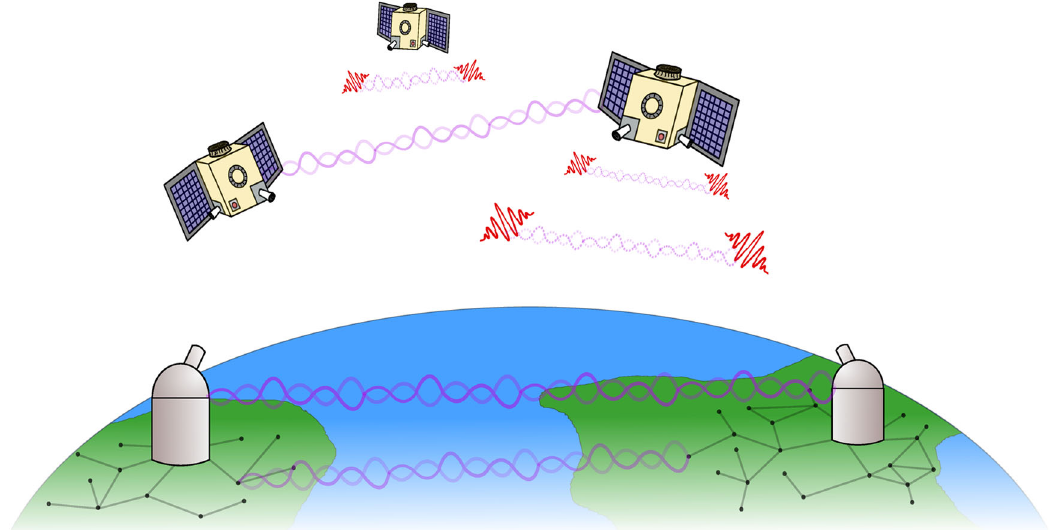
Fig. 1 A hybrid global quantum communications network. A satellite constellation distributes entangled photon pairs (red wave packets; entanglement depicted by wavy lines) to distant ground stations (observatories) that host multimode quantum memories for storage 114 – 116 . These stations act as hubs that connect to local nodes (black dots) via fi ber-optic or atmospheric links. Using these nearest-neighbor entangled links, via entanglement swapping, two distant nodes can share entanglement. Note that this architecture can support inter-satellite entanglement links as well, which is useful for exploring fundamental physics 60 , and for forming an international time standard 55 .